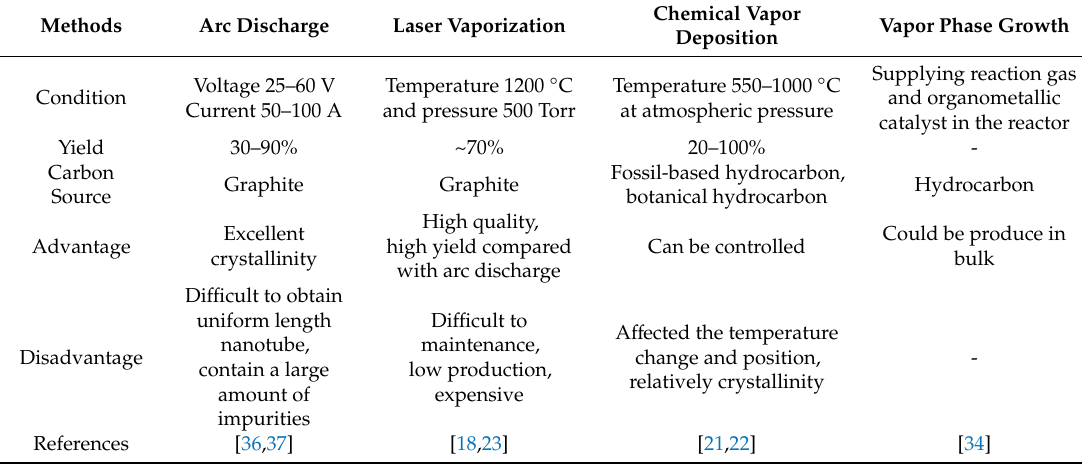
Table 2. A comparative study of di ff erent types of methods used in the synthesis of